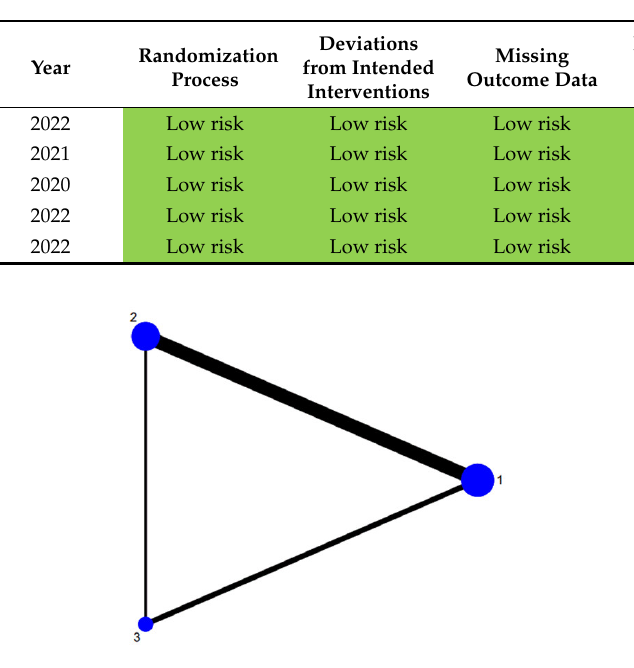
Table 2. Assessment of the risk of bias of included RCTs.